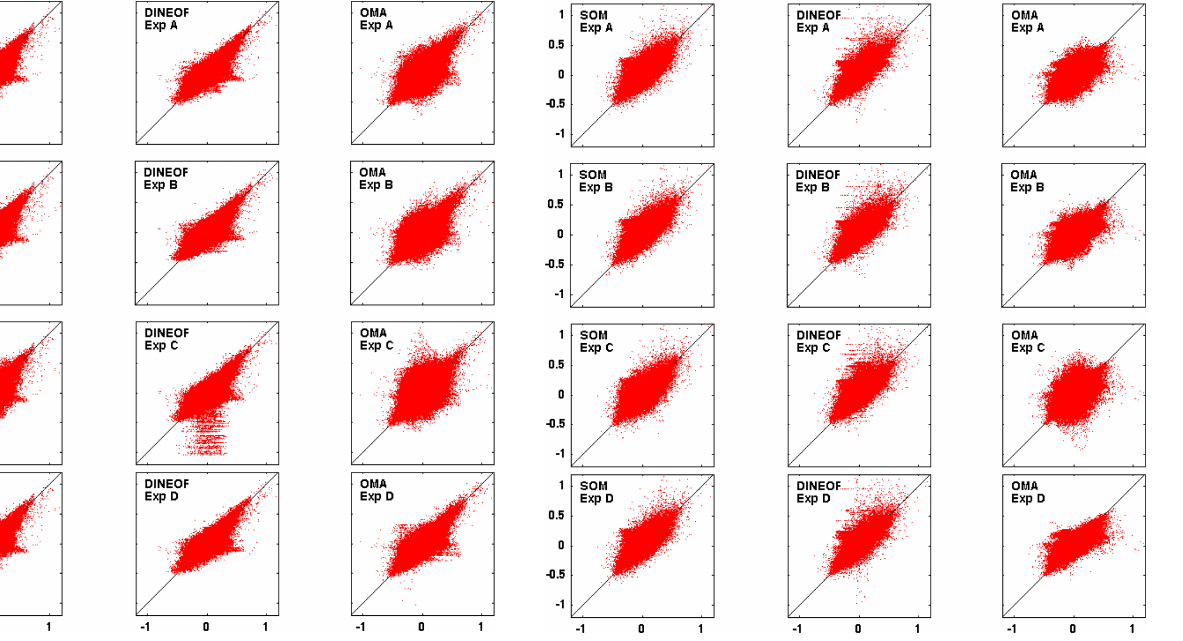
Figure 6. Scatterplot of the SOM model (a) , DINEOF (b) and OMA (c) reconstructed meridional velocities vs. observations for the four experiments